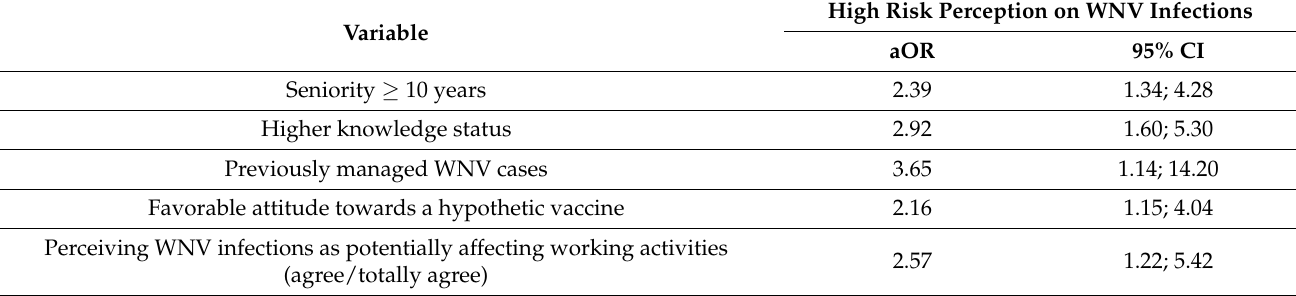
Table 3. Multivariable analysis of factors associated with having high risk perception WNV infections. Adjusted odds ratios (aOR) and their respective 95% confidence intervals were calculated through binary logistic regression analysis, including as explanatory variables all factors that in univariate analysis were associated with the outcome variables with p <